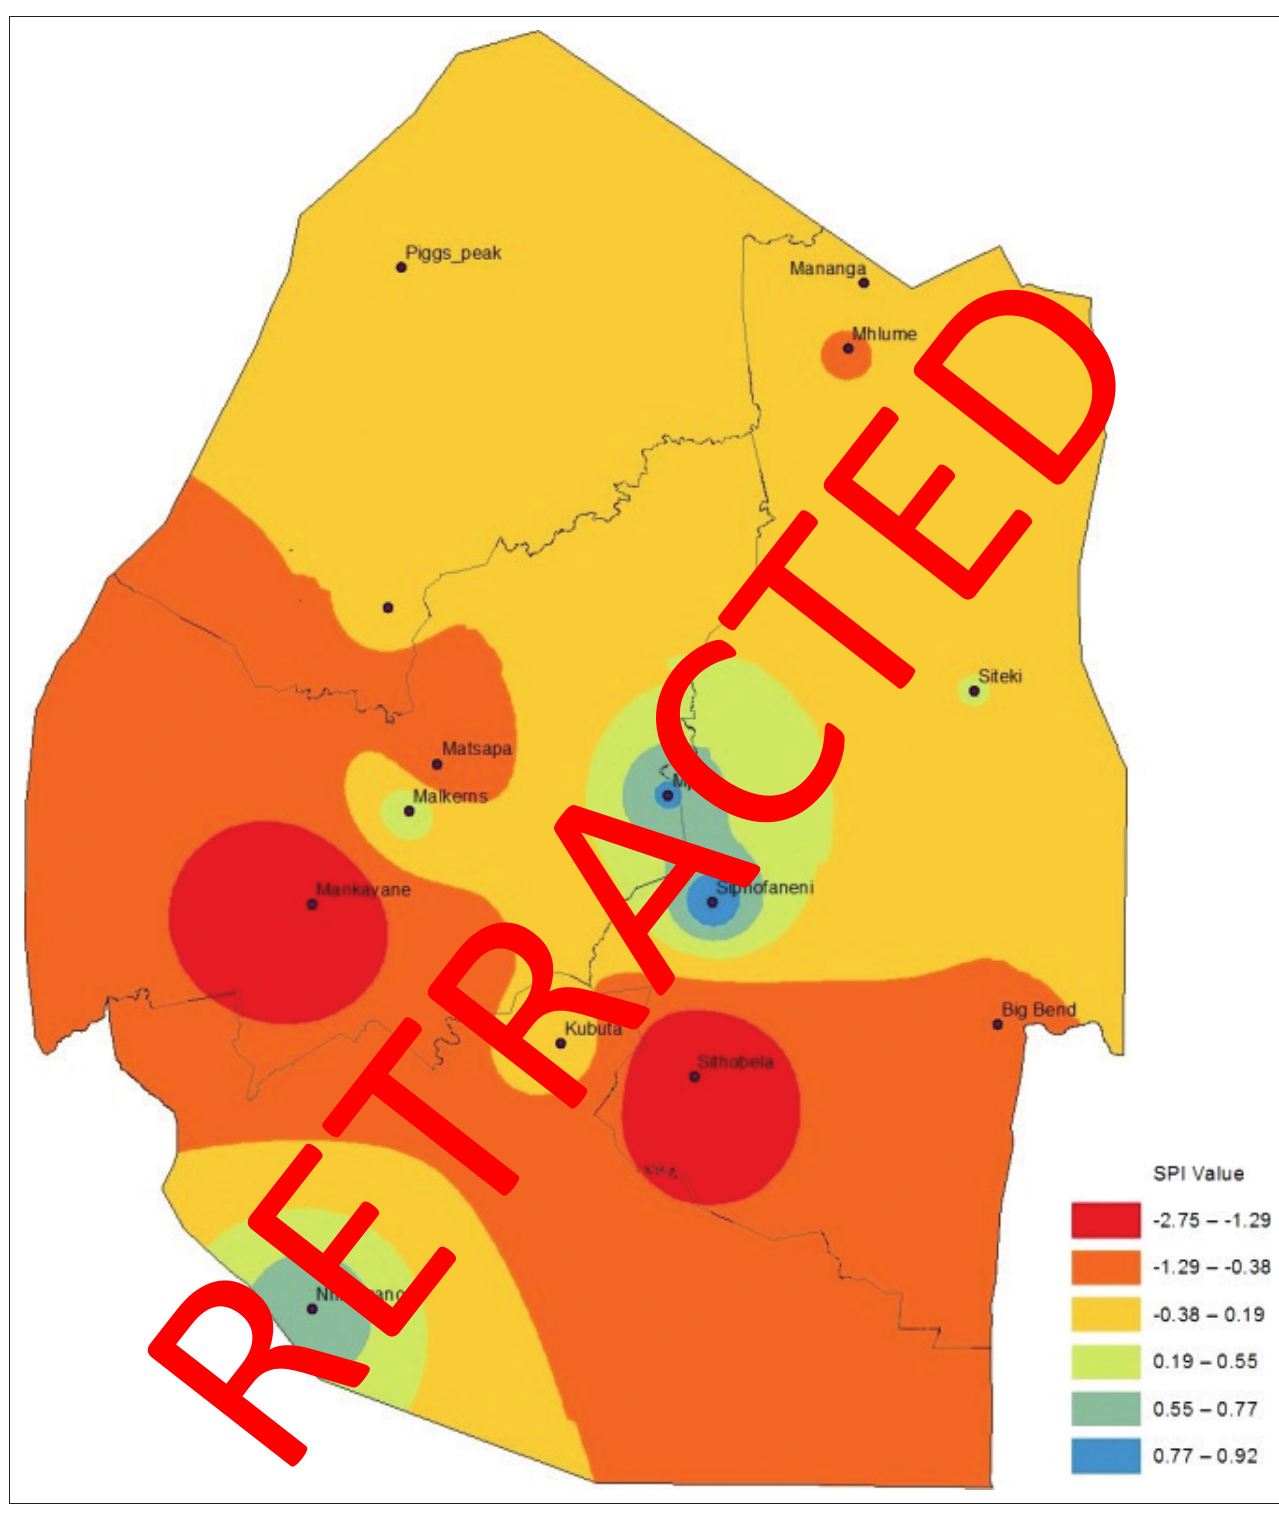
FIGURE 8: Standard Precipitation Index 3-month timescale during